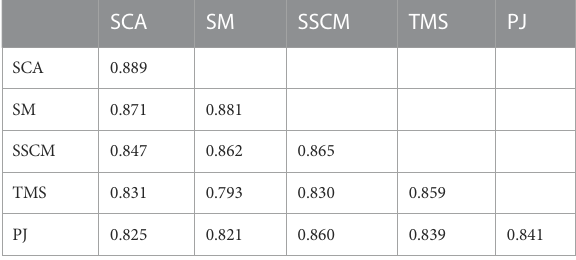
TABLE 3 Discriminant validity by the Fornell and Larcker